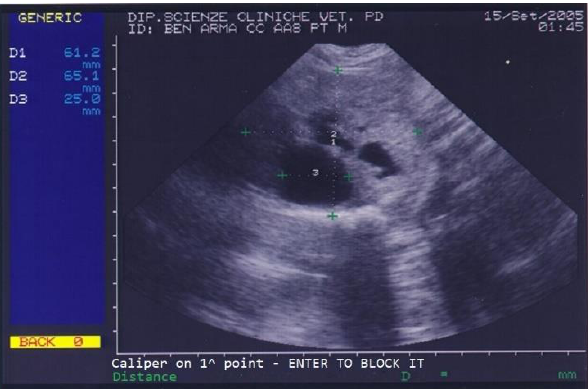
Figure 2. Abdominal ultrasonography of a German shepherd dog before deslorelin implant. The scan shows the ultrasonographic appearance of the prostate and the presence of different-sized cysts. The prostate’s perpendicular diameters are measured as D1 = 61.2 mm and D2 = 65.1 mm. The largest prostatic cysts’ diameter is measured as D3 = 25 mm.